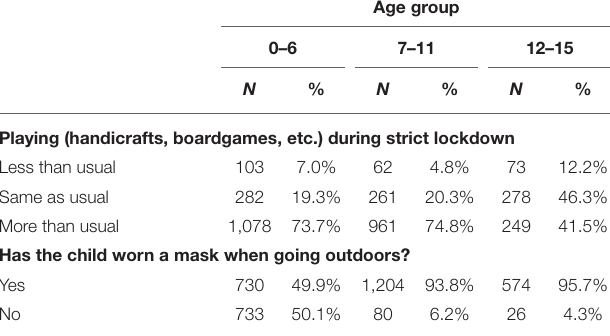
TABLE 2 | Answers about sleeping troubles, sports, and electronic devices use reported by parents for each child, distributed by age